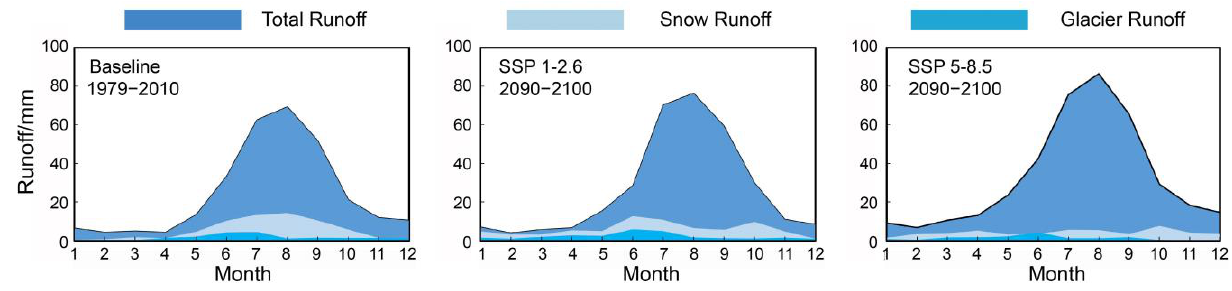
Figure 7. The runoff, and its components, in the reference period (1979–2010) and the end of the 21st century (2090 – 2100) under SSP 1-2.6, SSP 2-4.5 and SSP 5-8.5.